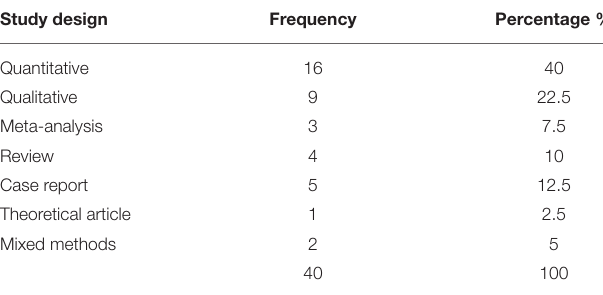
TABLE 1 | Type of